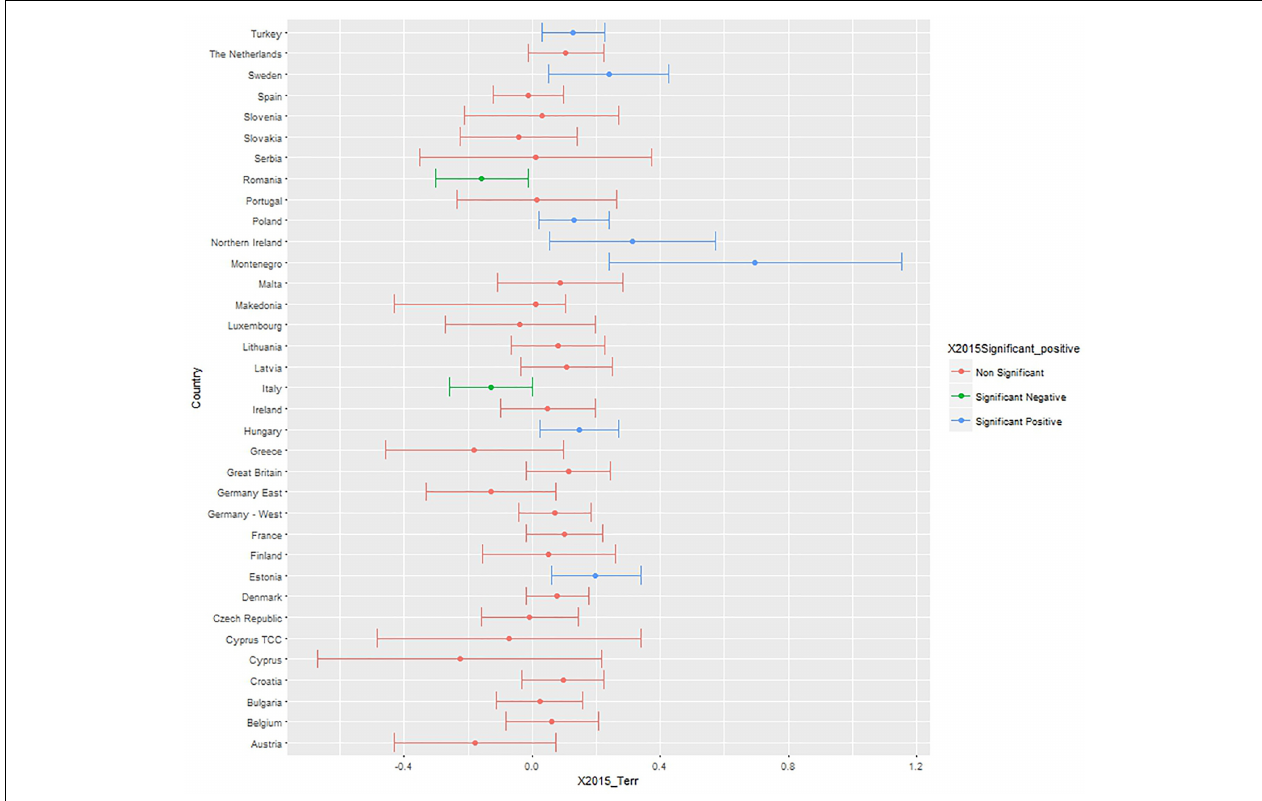
FIGURE 2 | Unstandardized B and confidence intervals of the terrorism threat coefficient ( x -axis) predicting negative attitudes toward the EU, controlling for age, gender, political orientation, realistic, and symbolic threats. Data: Eurobarometer 2015. Red bars indicate non-significant associations, blue significant and positive associations, and green significant and negative